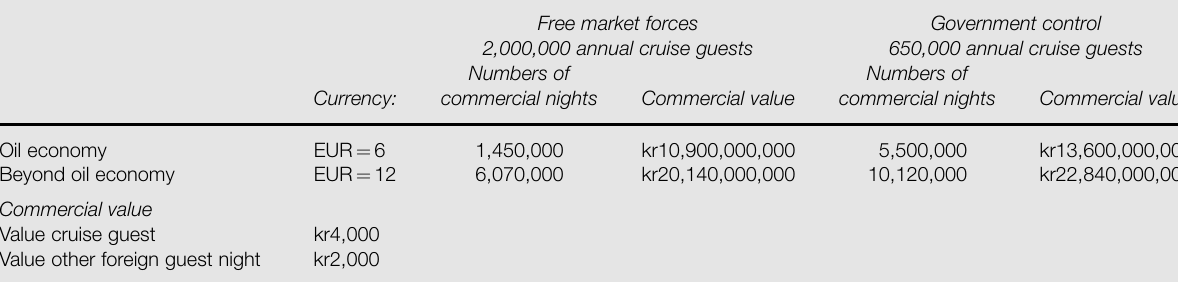
Table I Foreign tourism in Norway under the four